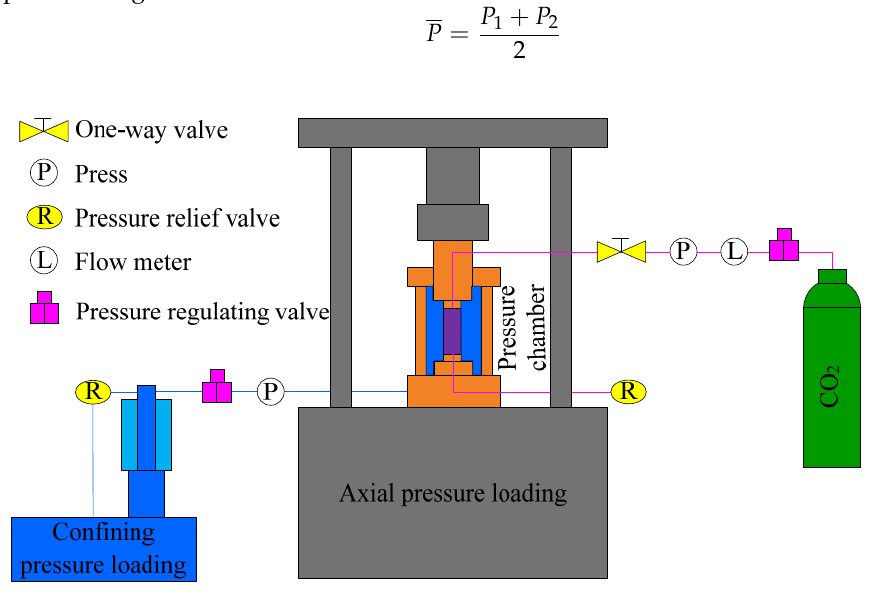
Figure 4. Schematic diagram of permeability test principle.